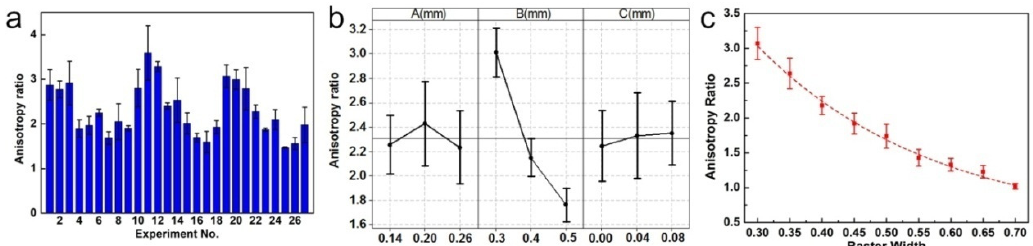
Figure 5. Resistivity anisotropy of 3D ‐ printed ABS/CB parts. ( a ) Anisotropy ratio of the printed parts in different parameter combinations from factorial design; ( b ) the main effects of the anisotropy ratio, including average values and standard deviations; an ( c ) the relationship between the anisotropy ratio and raster width ranged from 0.30 to 0.70 mm at intervals of 0.05 mm.